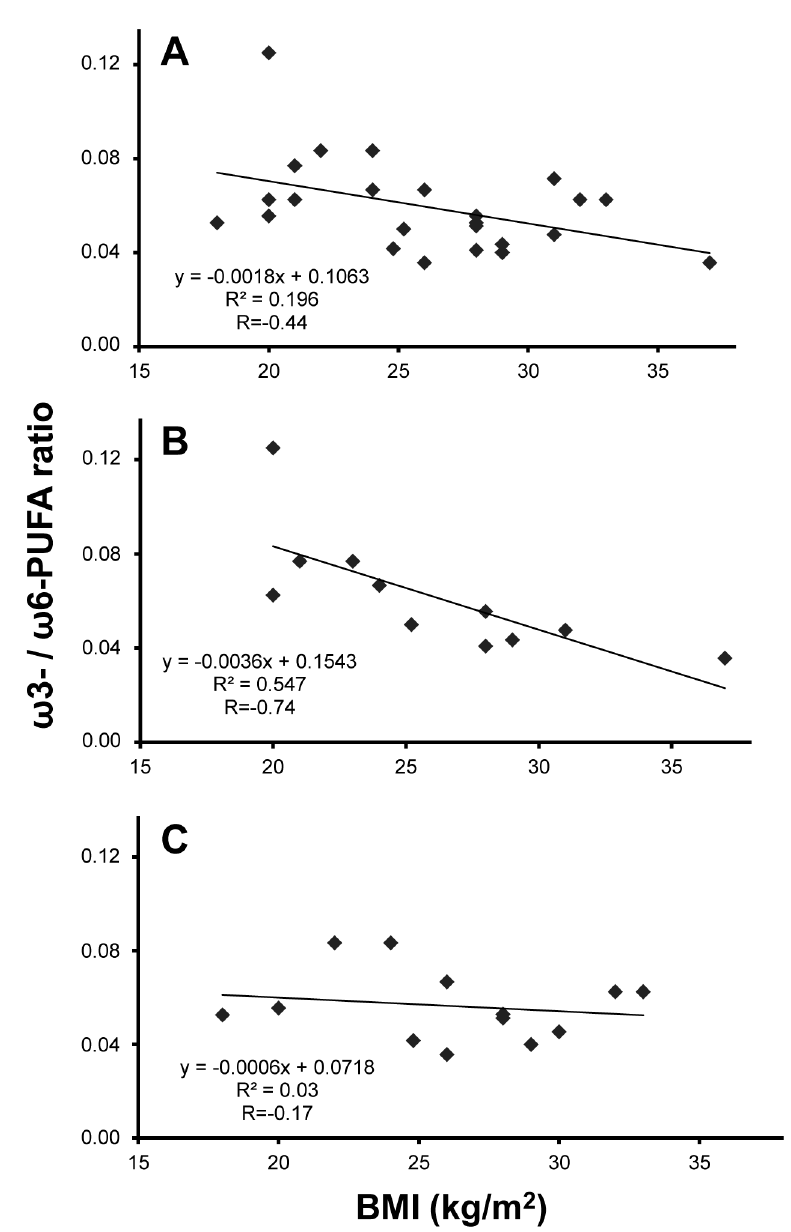
Figure 2. Linear regression analysis between ω3-/ω6-PUFA ratio and Body Mass Index (BMI). A : all subjects; B : subjects without colorectal cancer; C : subjects affected by colorectal